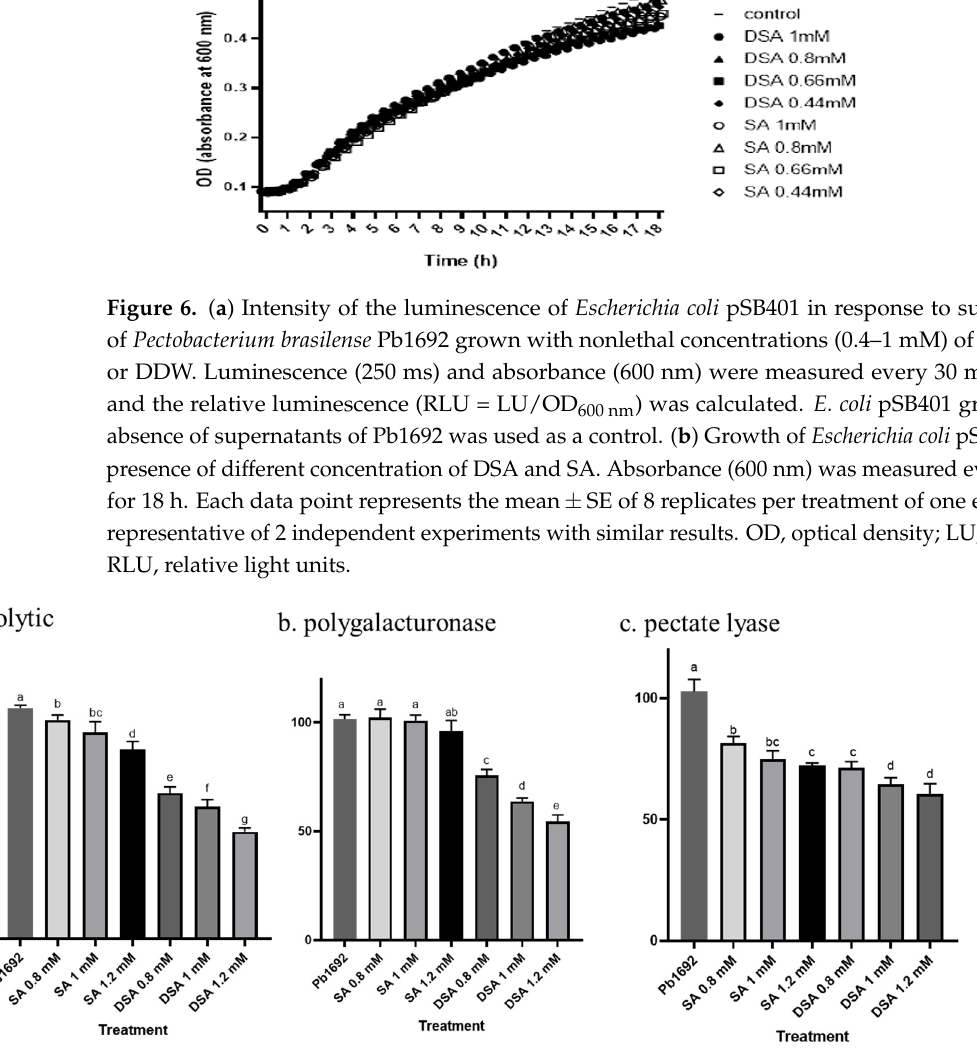
Figure 7. Effects of SA and DSA on Pb1692’s exoenzyme activity. Enzymatic activity was determined following overnight exposure of bacterial suspensions to nonlethal concentrations of the tested compounds. ( a ) Pectate lyase, Pel, ( b ) polygalacturonase, Peh, and ( c ) proteaseolytic, Prt. Activity levels were inferred from the size of the haloes caused by substrate degradation. Results are expressed as halo area relative to the control (DDW-treated bacteria). Bars that are not labelled with the same letter are significantly different from each other ( p < 0.05; bar = SE; n = 4). One-way ANOVA and post hoc Tukey-Kramer HSD tests were used to analyze differences. The analysis was performed using GraphPad Prism 8.0.